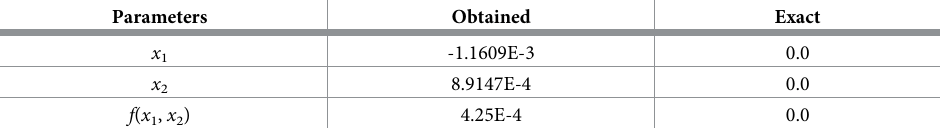
Table 3. Results of the PSO-Kmeans-ANMS algorithm for the Rastrigin function. The number of objective function evaluations in Phases 1 and 2 corresponds, respectively, to 1008 and 36.